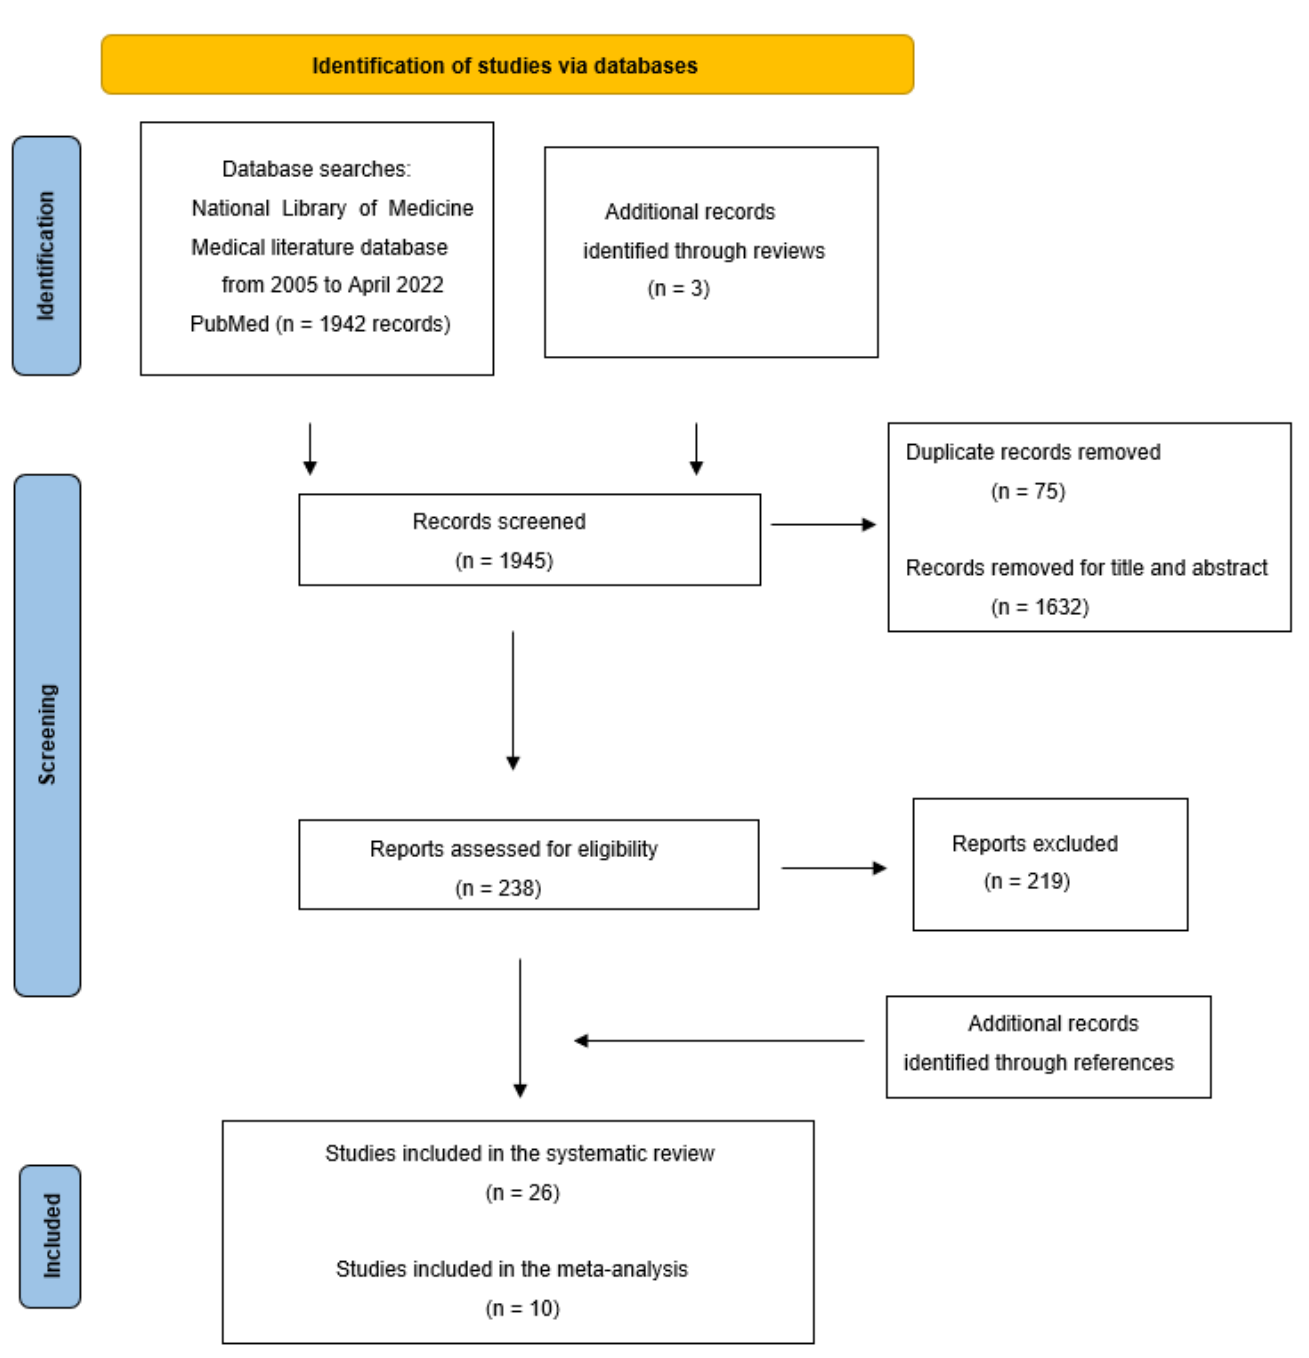
Figure 1. Systematic review flow diagram. The PRISMA flow diagram for the systematic review detailing the database searches, the number of abstracts screened and the full texts retrieved.